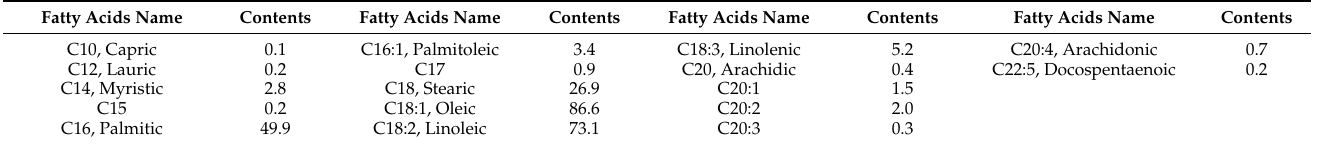
Figure 1. Experimental design. Mice were randomized into four groups: Rnls –/– -ND, Rnls +/+ -ND, Rnls –/– -HFD, and Rnls +/+ -HFD ( n = 5 in each group). IPGTT and IPITT were conducted in the seventh and eighth weeks of the experiment, respectively. Fecal samples were collected weekly. ♂ , male; Rnls –/– -ND, renalase gene knockout mice fed with normal diet; Rnls +/+ -ND, wild-type mice fed with normal diet; Rnls –/– -HFD, renalase gene knockout mice fed with high-fat diet; Rnls +/+ -HFD, wild-type mice fed with high-fat diet; IPITT, intraperitoneal insulin tolerance test; IPGTT, intraperitoneal glucose tolerance test. Table 1. Typical composition of fats used by research diet